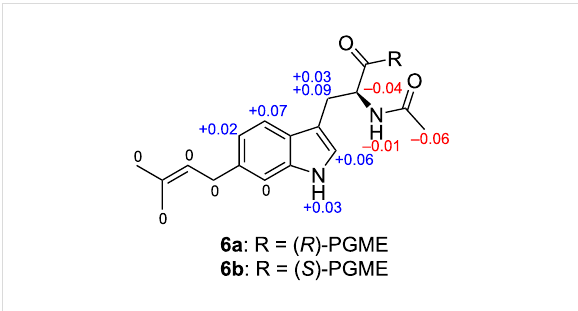
Figure 6: Δδ H ( S-R ) values in ppm calculated from PGME amides 6a and 6b .